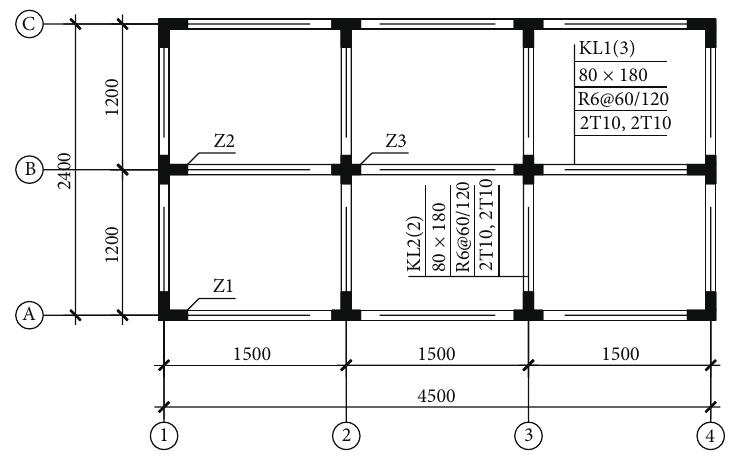
Figure 1: Dimensions of model